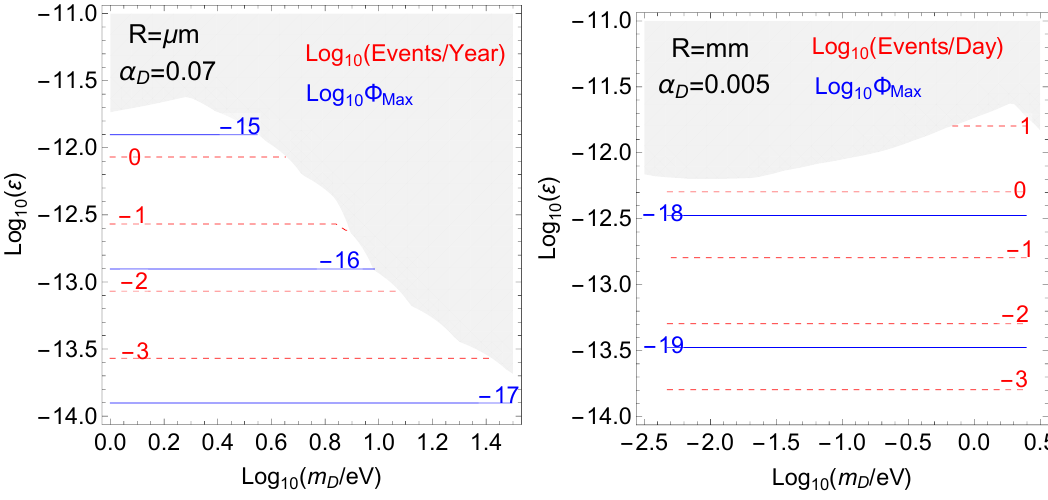
Figure 2 . Blue solid contours of maximum AB phase shift and on the left (right) red dashed contours of the expected number of AB event per second (year) from solar excitation (assuming the monopoles make up 10% of the DM) as a function of the dark photon mass m D and the kinetic mixing " . The characteristic size of the detector on the left (right) is R = 1 mm ( (cid:22) m) and (cid:11) D = 0 : 07 (0.005). The monopole mass is M =1 keV. The gray region is excluded by dark photon constraints or leads to the dark sector thermalizing withe the